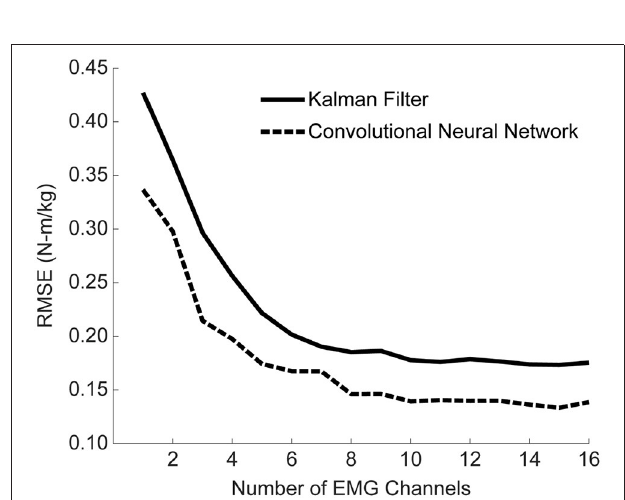
FIGURE 9 | Mean algorithm performance across all training conditions as a function of the number of EMG channels used. Performance is shown as RMSE (N-m/kg) of algorithm predictions relative to the ground truth values of right and left hip torque in the sagittal plane. Channels were selected using a Gram-Schmitt channel selection algorithm. Both the KF and CNN improve with additional channels, although the majority of the improvement comes with the first eight channels. Note that the 16 channels used here consist of eight muscles groups recorded bilaterally, although the eight channels selected were rarely